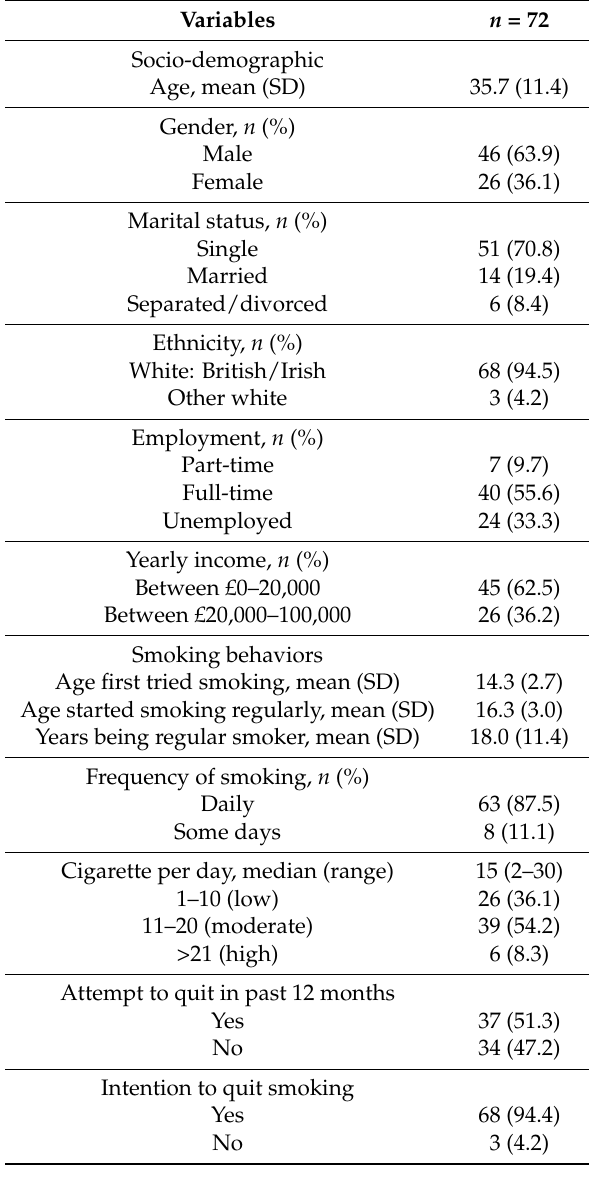
Table 1. Baseline Socio-Demographic Characteristics and Smoking